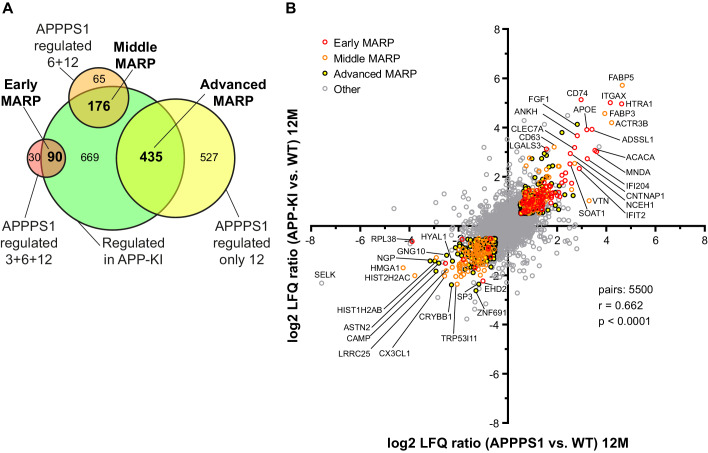
Comparison of the early, middle and advanced MARPs in APPPS1 and APP-KI mice.(A) A Venn diagram illustrates the classification of regulated proteins into early, middle and advanced MARPs. Proteins that were regulated at 3, 6, and 12 months in APPPS1 mice as well as at 6 and 12, or only at 12 months in APP-KI mice were annotated as early MARPs. Proteins that were regulated at 6 and 12 months in APPPS1 as well as at 6 and 12, or only at 12 months in APP-KI mice were annotated as middle MARPs. Proteins that were regulated at 12 months in APPPS1 and APP-KI mice were annotated as advanced MARPs. (B) Correlation plot of log2 protein fold changes detected at 12 months for APPPS1 and APP-KI versus WT. The plot shows a significant correlation of proteomic changes at 12 months. Early, middle, and advanced MARPs are indicated in red, orange, and black circles, respectively. Selected proteins are annotated with their gene names.